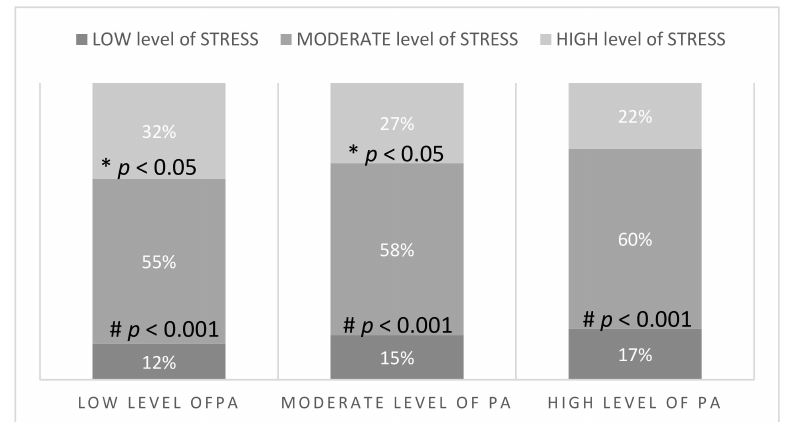
Figure 2. Number and the percentage of participants ( n = 1956) with a specific level of stress depending on the level of PA. * p -value LOW vs. HIGH across different level of PA groups, # p -value MODERATE vs. LOW and HIGH across different level of PA groups.